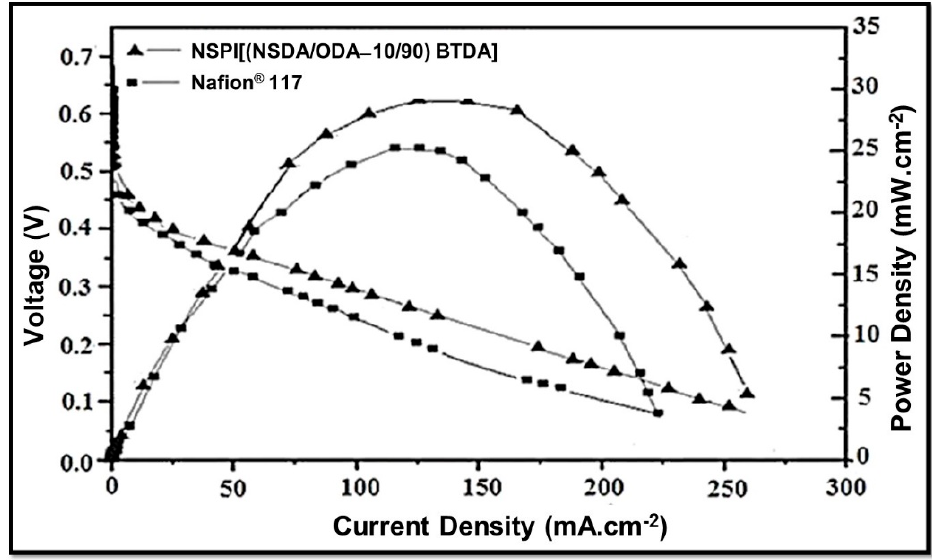
Figure 7. Evaluation of NSPI 10 and Nafion ® 117 membranes at 70 °C in DMFC. 28.5 mW.cm − 2 to 34.75 mW.cm − 2 with the rise in temperature from 70 ◦ C to 140 ◦ C, which is clearly an indication of its stability and suitability for DMFC applications (Figure 8).